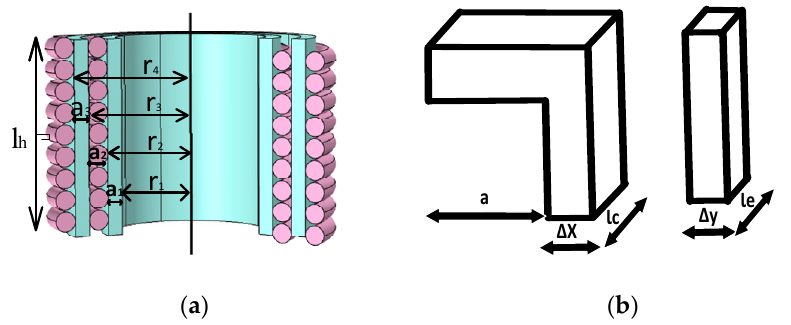
Figure 2. ( a ) Schematic diagram of winding multi-layer cylinder; ( b ) Core structural parameters diagram.